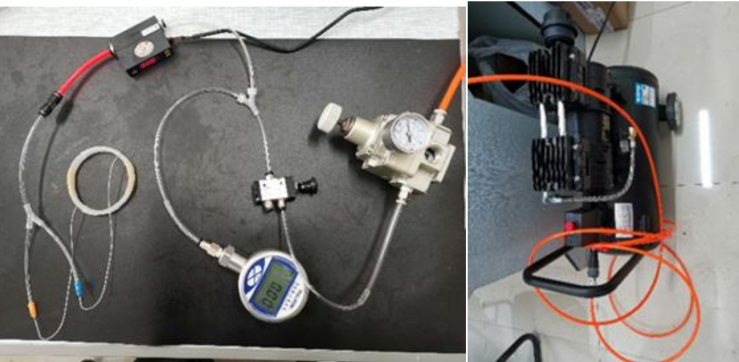
Figure 2. Pneumatic control platform for fiber-constrained annular flexible